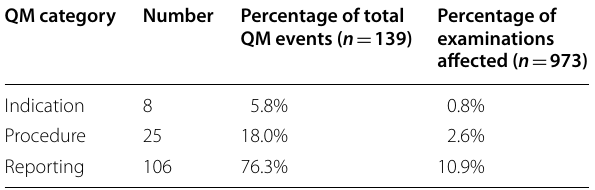
Table 4 Quality management (QM)